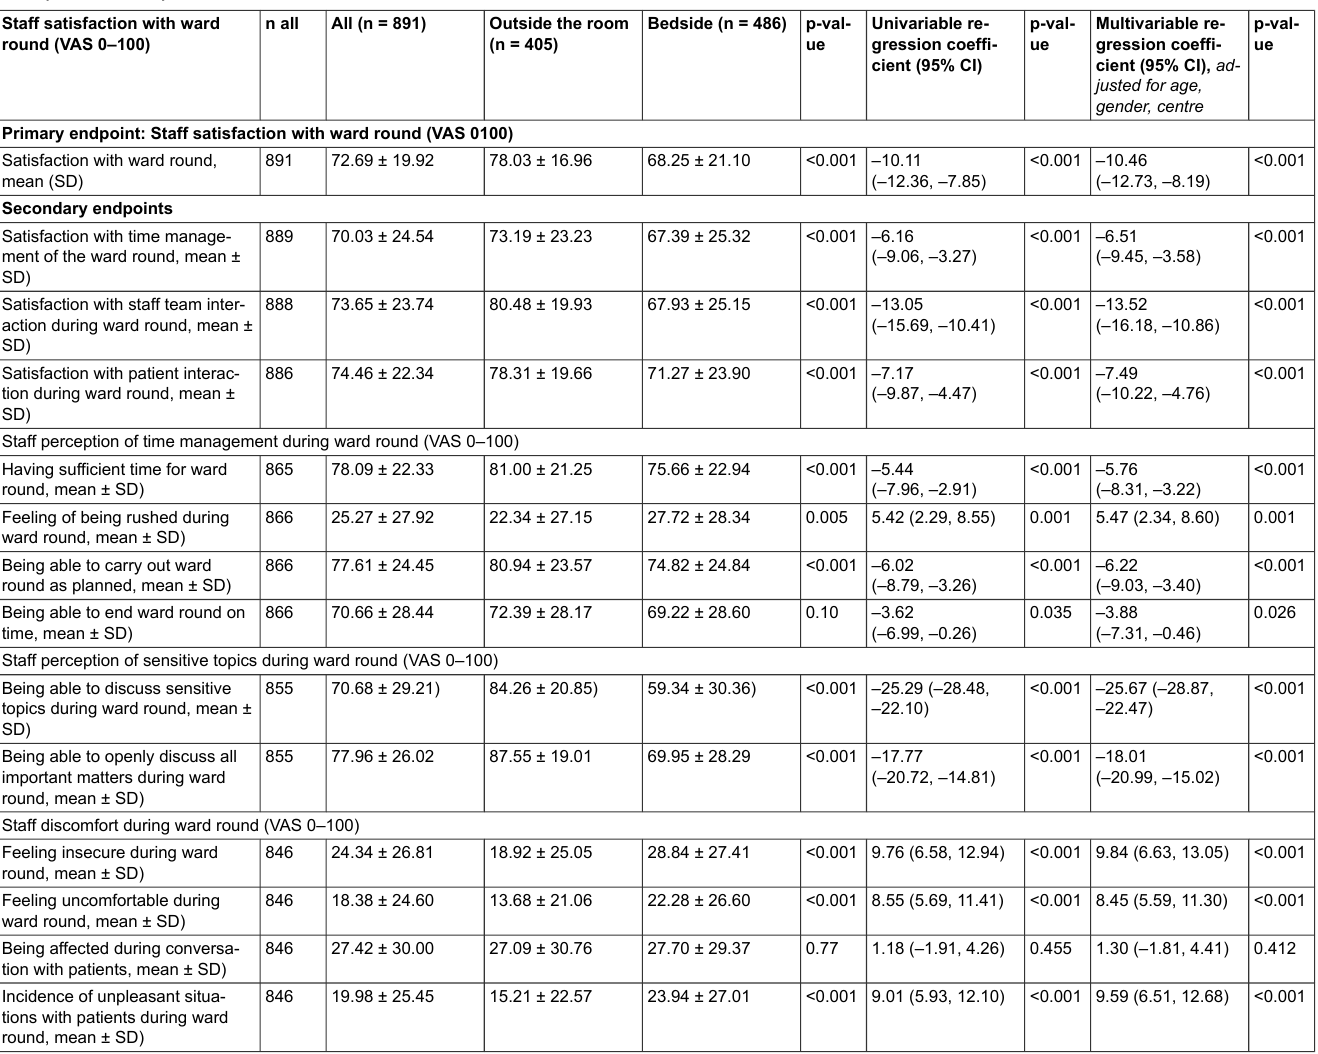
Table 2: Primary and secondary